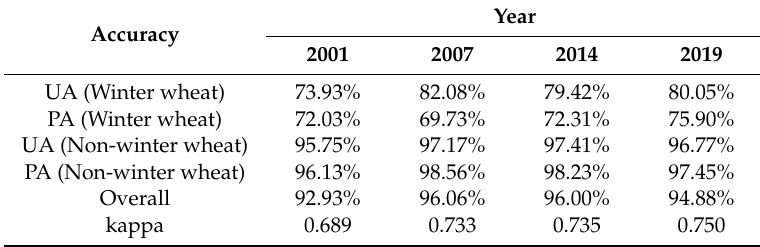
Table 3. Accuracy assessment using Landsat-interpreted images from 2001 to